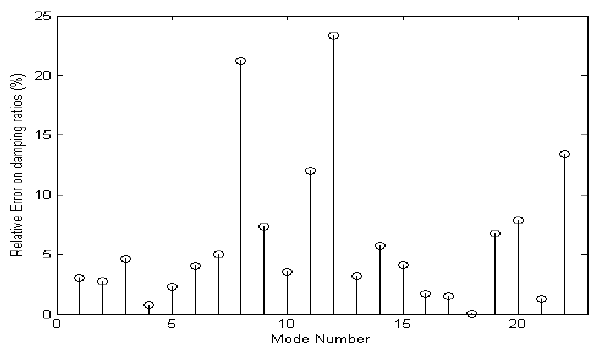
Fig.4 Relative errors on damping ratios